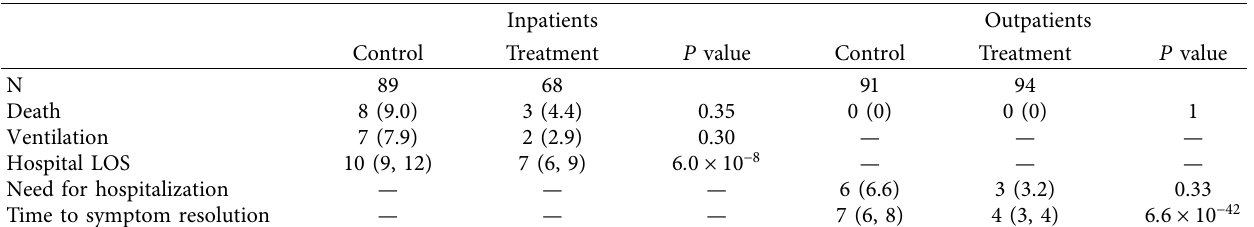
Table 2: Outcomes of the mebendazole treatment group and the nonmebendazole treatment group for both inpatients and